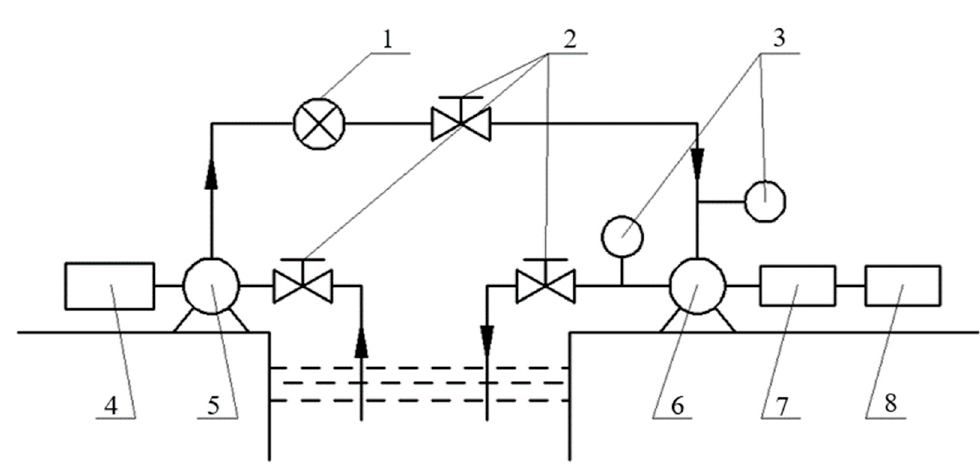
Figure 4. Experimental system layout. ( 1 ) Magnetic flow meter; ( 2 ) control valve; ( 3 ) pressure